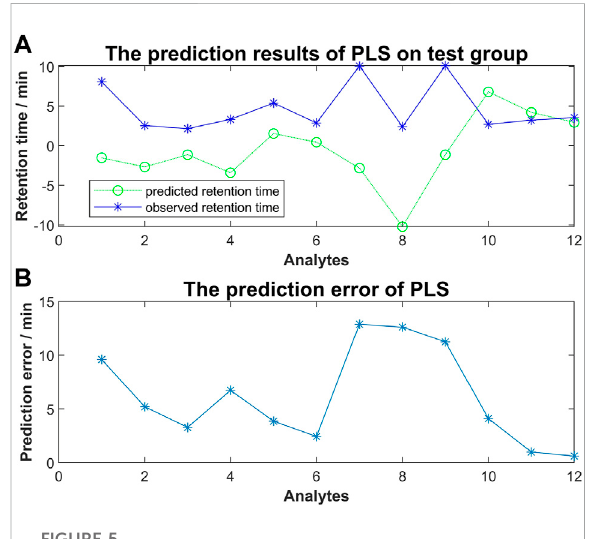
FIGURE 5 (A) The predicted retention time obtained by PLS method vs. observed retention time; (B) The prediction error of PLS for each analyte of the test